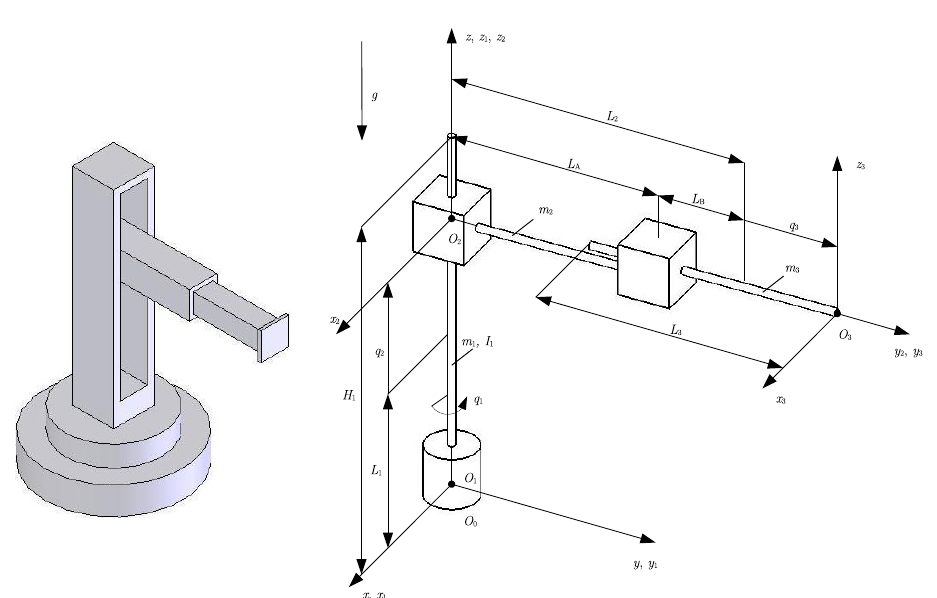
Figure 3. Computer model and schematic representation of a robot manipulator with three degrees of freedom.